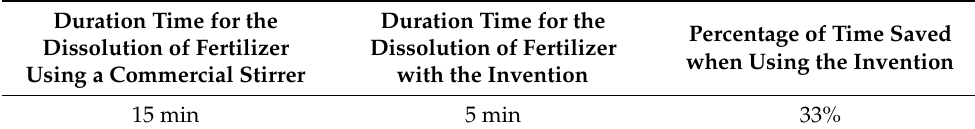
Table 4. Data of time saved as a result of using the invention between a commercial mixer and the automatic equipment for dissolving solid